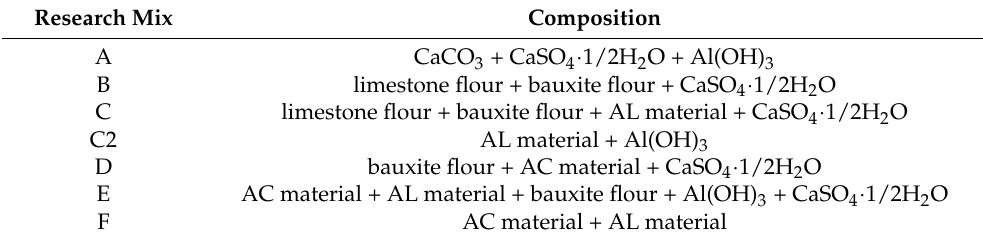
Table 1. List of tested